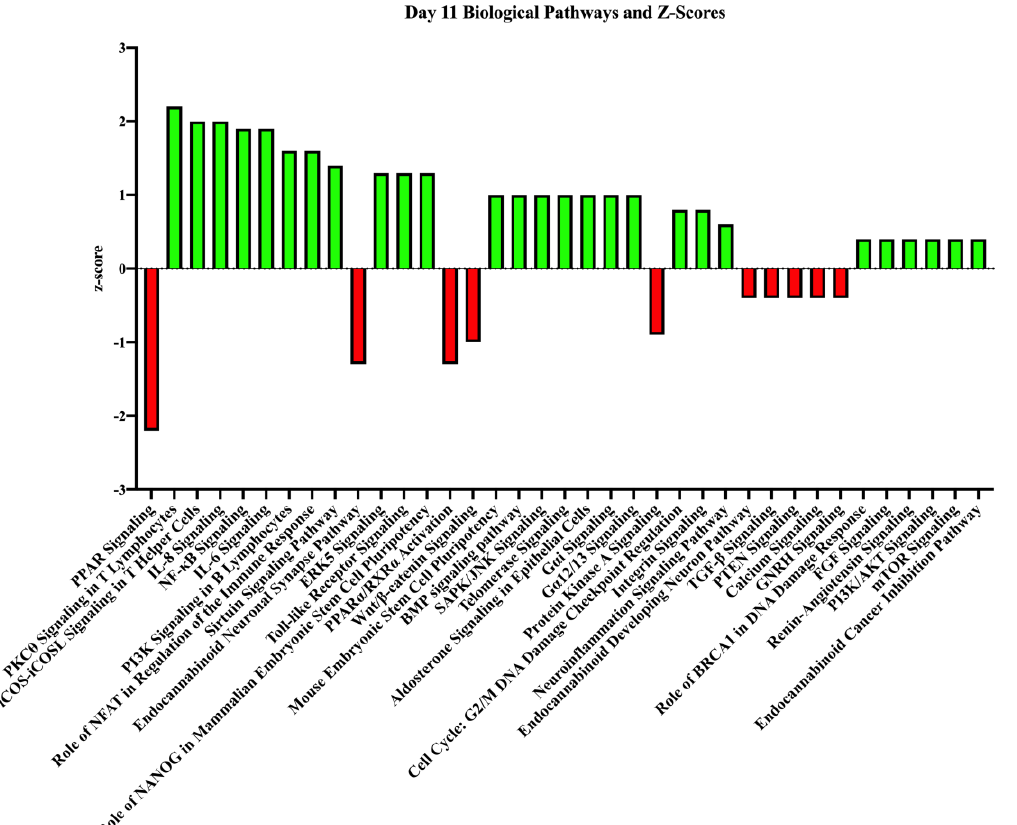
Figure 4. Top biological processes and z-scores on day 11 in endometrial samples from pregnant and non-pregnant mares. These are the biological processes associated with the genes of higher abundance in the given pregnancy status on day 11. The z-score indicates the association strength with activating (green bars) or inhibiting (red bars) a pathway due to the sample being obtained from a pregnant mare.